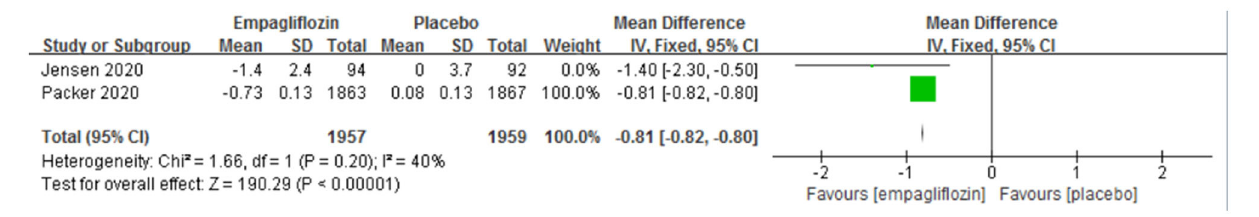
FIGURE 9 | Effect of empagliflozin on the change in body weight from baseline in HFrEF